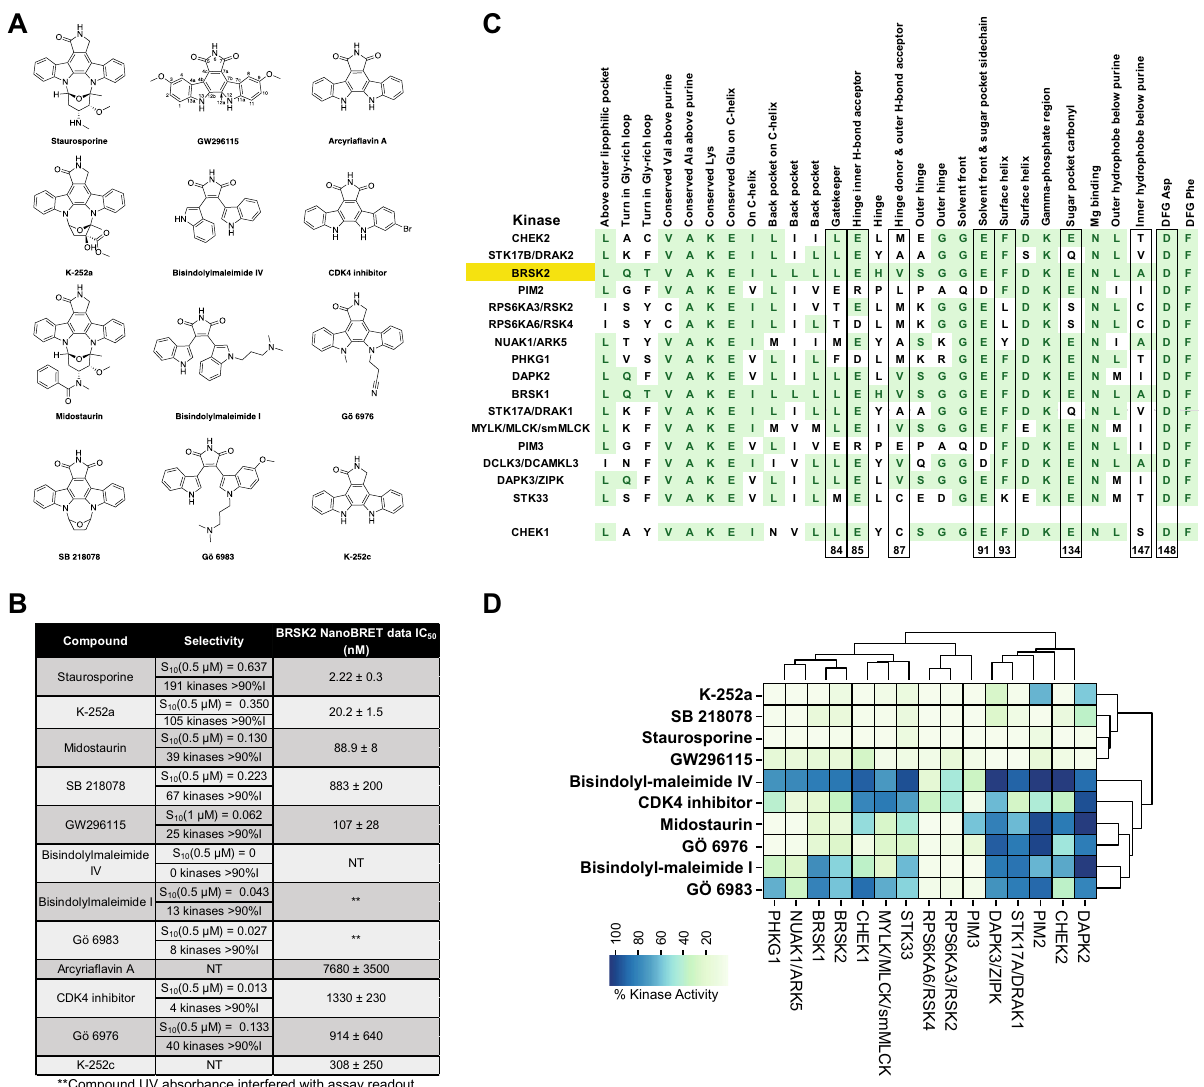
Figure 5. Structural- and activity-based comparisons of GW296115 to related compounds. ( A ) Structures of staurosporine, K-252a, midostaurin, SB 218078, bisindolylmaleimide IV, bisindolylmaleimide I, Gö 6983, Arcyriaflavin A, CDK4 inhibitor, Gö 6976, and K-252c versus GW296115. ( B ) Selectivity of compounds shown in panel A when profiled against 300 (staurosporine, K-252a, midostaurin, SB 218078, bisindolylmaleimide IV, bisindolylmaleimide I, Gö 6983, CDK4 inhibitor, and Gö 6976) or 403 (GW296115) wild type human kinases and NanoBRET data for most inhibitors in panel A (N = 3). ( C ) Alignment of key residues corresponding to CAMK kinases potently inhibited by GW296115 and CHEK1. Residues colored green demonstrate homology shared with BRSK2 and residue numbers listed below correspond with those discussed with respect to SB 218078 binding to CHEK1 (also boxed). ( D ) Inhibition data corresponding with those CAMK kinases (and CHEK1) included in profiling of inhibitors listed in panel A. Python version 3.8 was used to make heatmap in ( D